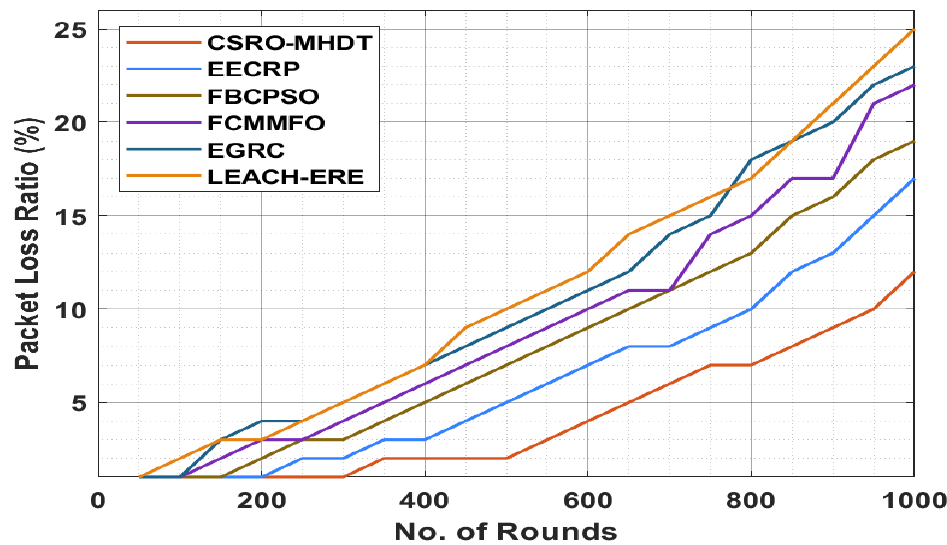
Figure 6. PLR analysis of the CSRO-MHDT technique in comparison with existing approaches. Table 6. NPR analysis of the CSRO-MHDT technique in comparison with existing